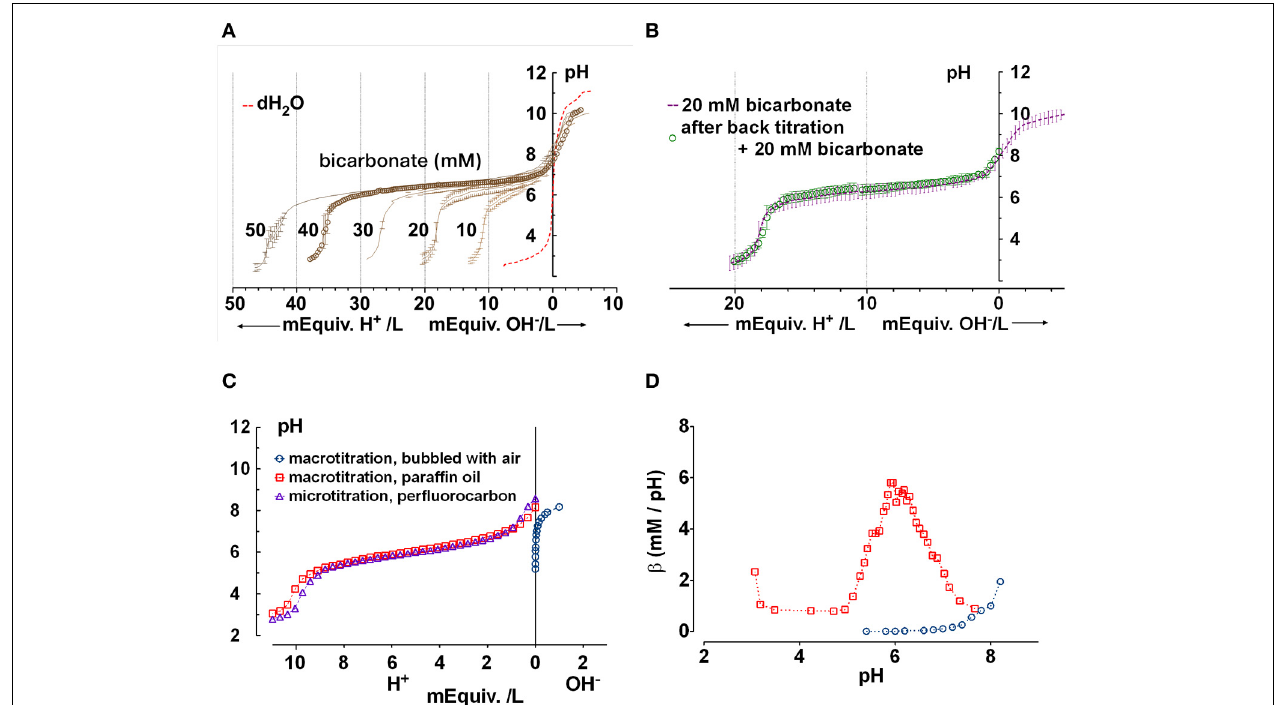
FIGURE 2 | Confirmation that the chamber approximates a closed system for CO 2 /HCO − 3 . (A) Microtitration curves obtained for pure solutions having sodium HCO − 3 concentrations between 10 and 50mM. Unbuffered water is shown for comparison (dashed red line). Means ± SD, n = 3–5. (B) Reproducibility of microtitrations. A sample of 20mM HCO − 3 solution was microtitrated with HCl, neutralized using NaOH, supplemented with 20mM HCO − 3 by injection of concentrated HCO − 3 solution, and re-titrated. The second titration curve (open circles) was within the standard deviation of the initial curve. Means ± SD, n = 3–5.